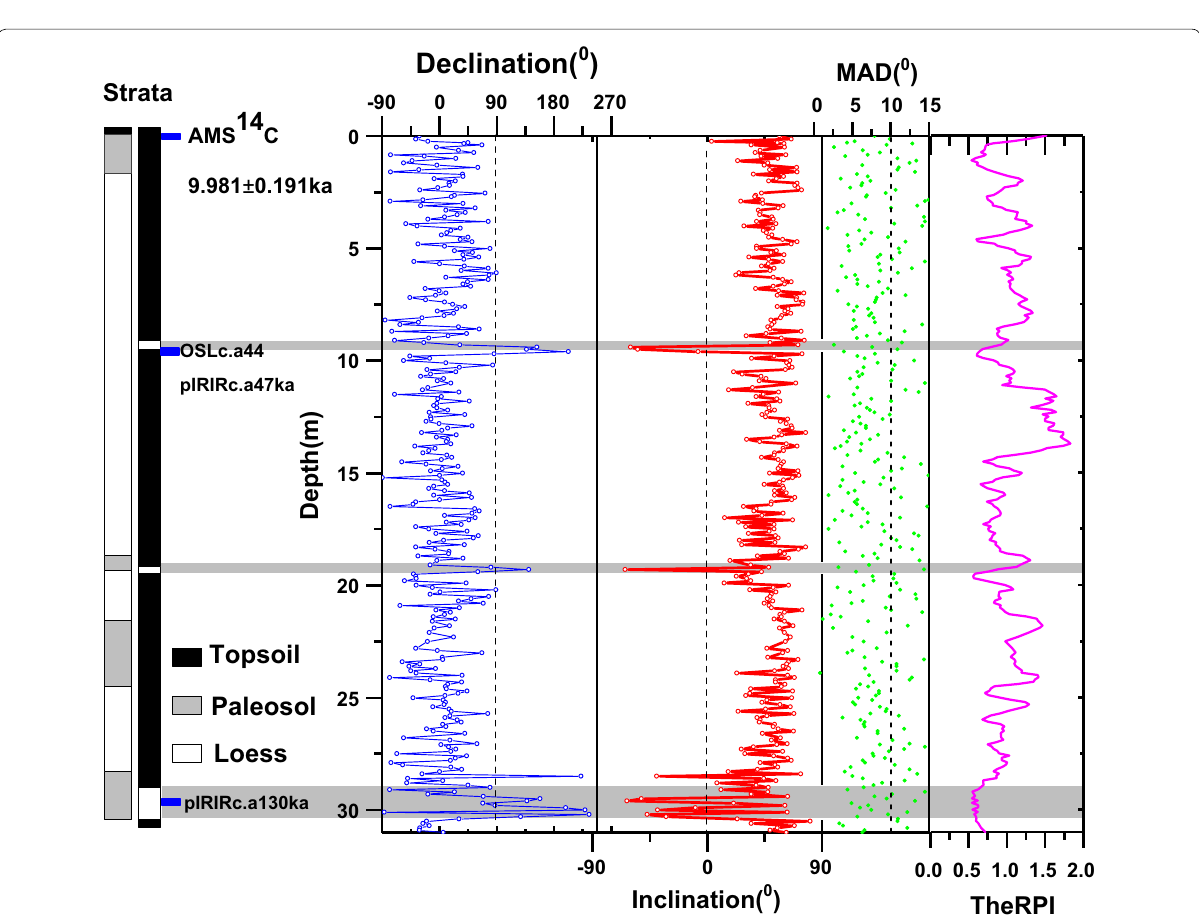
Fig. 8 Magnetostratigraphy results of the BYH loess section. The polarity zonation is defined by inclination and declination of the ChNRM derived from continuous four points with PCA. Tie point ages are shown at the left side, obtained by radiocarbon dating (AMS), and optically stimulated luminescence dating of quartz (OSL) and feldspar (pIRIR). (Reproduced with permission from Li et al.